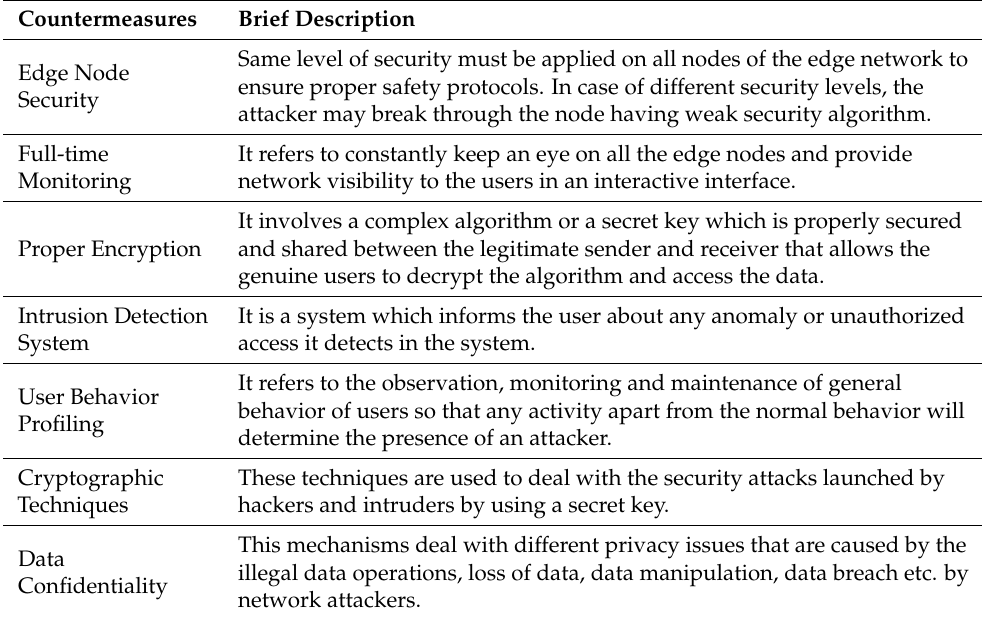
Table 5. Security attacks and privacy-preserving countermeasures in edge.